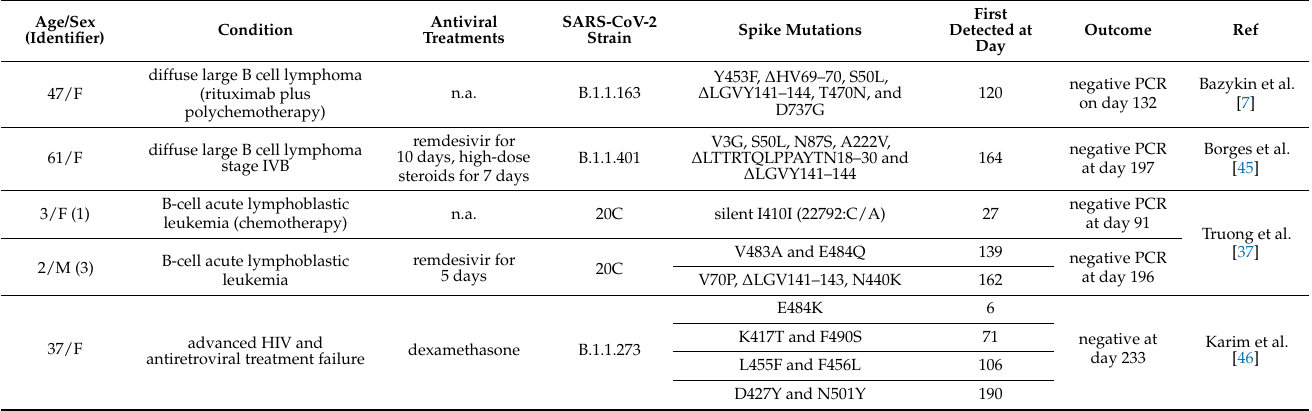
Table 4. Intrahost variation in spike sequence detected in immunocompromised patients not receiving nAb-based